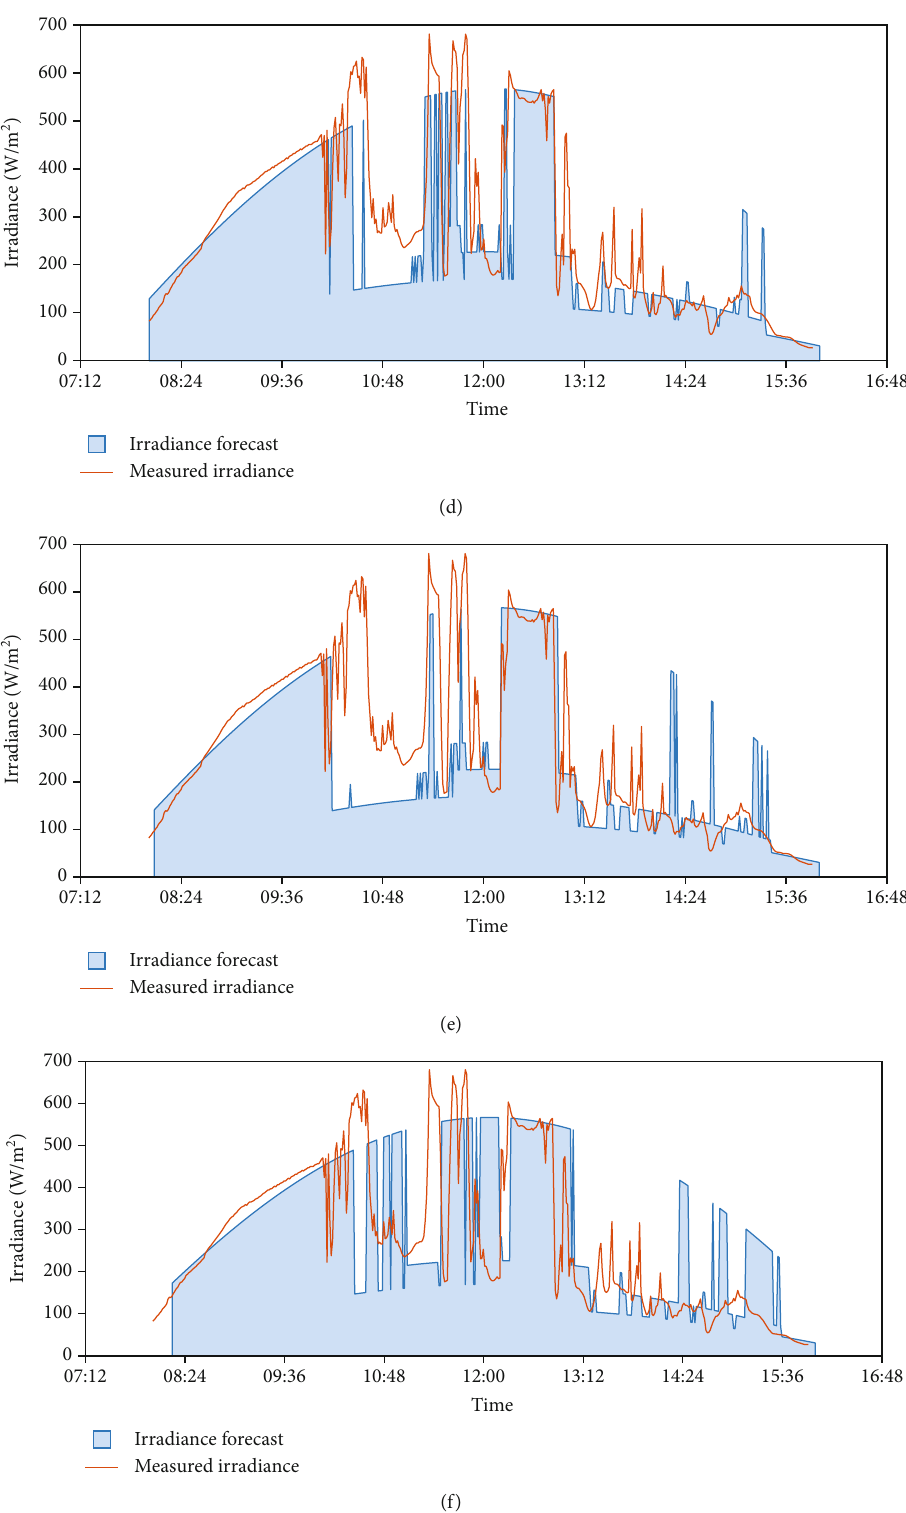
Figure 17: (a) 1 minute, (b) 5 minutes, and (c) 15 minutes forecasts at location 1 on 9 th April 2019 and (d) 1 minute, (e) 5 minutes, and (f) 15 minutes forecasts at location 3 on 29 th